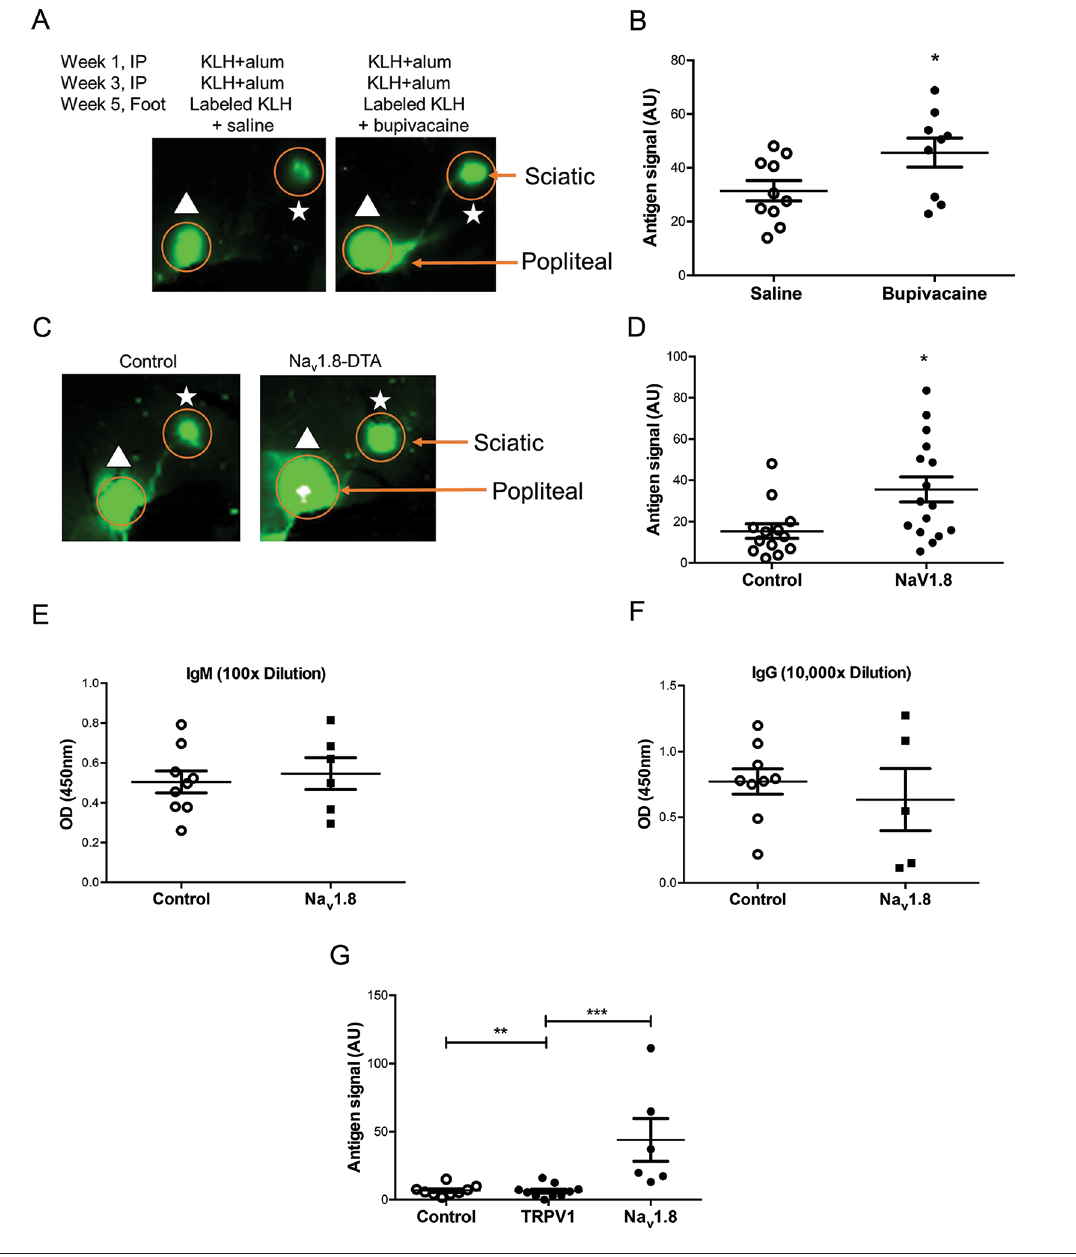
Figure 3. Antigen flow restriction is dependent on sensory neural input. (A, B) Mice immunized with KLH were injected with bupivacaine at the femoral and sciatic nerves. Upon challenge with KLH-800CW, an increase in antigen signal was seen in the sciatic lymph node. (A) Images are representative; triangles indicate popliteal lymph nodes and stars represent sciatic lymph nodes. (B) Antigen signal in the sciatic lymph node in individual animals is shown here. (mean ± SEM: saline, 31.45 ± 3.759, n = 10, bupivacaine, 45.65 ± 5.350, n = 9, p < .05 by t test). (C, D) Na 1.8-DTA mice were immunized with KLH. Images are representative; triangles indicate popliteal lymph nodes V and stars represent sciatic lymph nodes. (D) Antigen signal in the sciatic lymph node in individual animals is shown here. (mean ± SEM control, 15.41 ± 3.526, n = 13; Na 1.8-DTA, 35.56 ± 6.035, n = 16, p < .05 by t test). (E, F) No difference in the circulating levels of (E) IgM v and (F) IgG was seen in Na 1.8-DTA mice (IgM, Na 1.8-depleted, 0.5044 ± 0.05477, n = 9 versus control, 0.5466 ± 0.08038, n = 6) (IgG, V V Na 1.8-depleted, 0.7737 ± 0.09626, n = 9 versus control, 0.6340 ± 0.2365, n = 5). (G) Immunized TRPV1-DTA, Na 1.8-DTA and littermate V V control mice were injected with KLH-800CW in the hind paw. The increase in antigen seen in Na 1.8–DTA mice was not recapitulated in V TRPV1-DTA mice in the sciatic lymph node (control, 6.783 ± 1.290, n = 9; TRPV1-DTA, 6.345 ± 1.547, n = 10; Na 1.8-DTA, 43.93 ± 15.57, n = 6, V p < .001 by one-way ANOVA Bonferroni post-test). Data represent individual values and mean ±